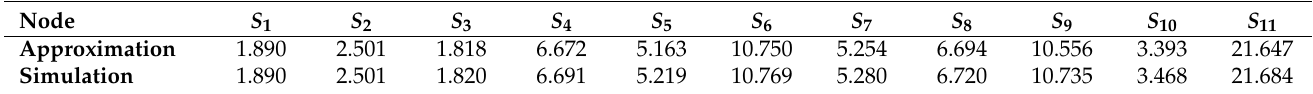
Table 2. Average sojourn times in the